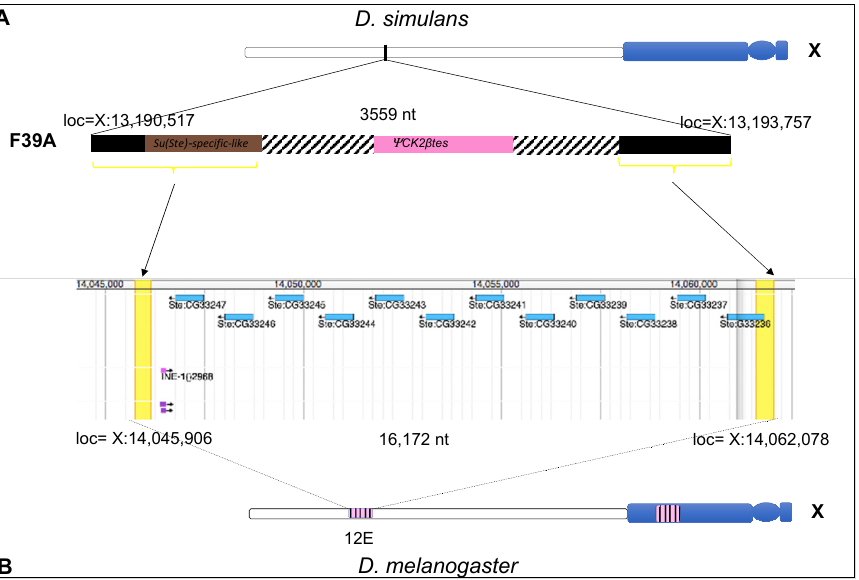
Figure 8. ( A,B ) Schematic of the F39A clone and its corresponding localization in the D. simulans and D. melanogaster X chromosome. In the X chromosome diagram, heterochromatin is depicted in blue, euchromatin in white, Ste and Ste -like in pink. ( A ) In the enlarged representation of the F39A clone are indicated, in brown, the Su(Ste) -specific-like region, and, in pink, the Ste -like corresponding to Ψ CK2 β tes. The nucleotide positions corresponding to both ends of F39A clone in D. simulans genome are indicated. ( B ) In the shaded part is represented the FlyBase Blast Report of JBrowse ( D. melanogaster , r6.45) obtained from the alignment of the F39A sequence; the nucleotide positions are indicated. Black arrows indicate the localization of the orthologous sequences of both ends of F39A, with the syntenic X-chromosome region of D. melanogaster . The F39A clone corresponds to the region in which Ste locus is located in D. melanogaster . All drawings are not to scale.